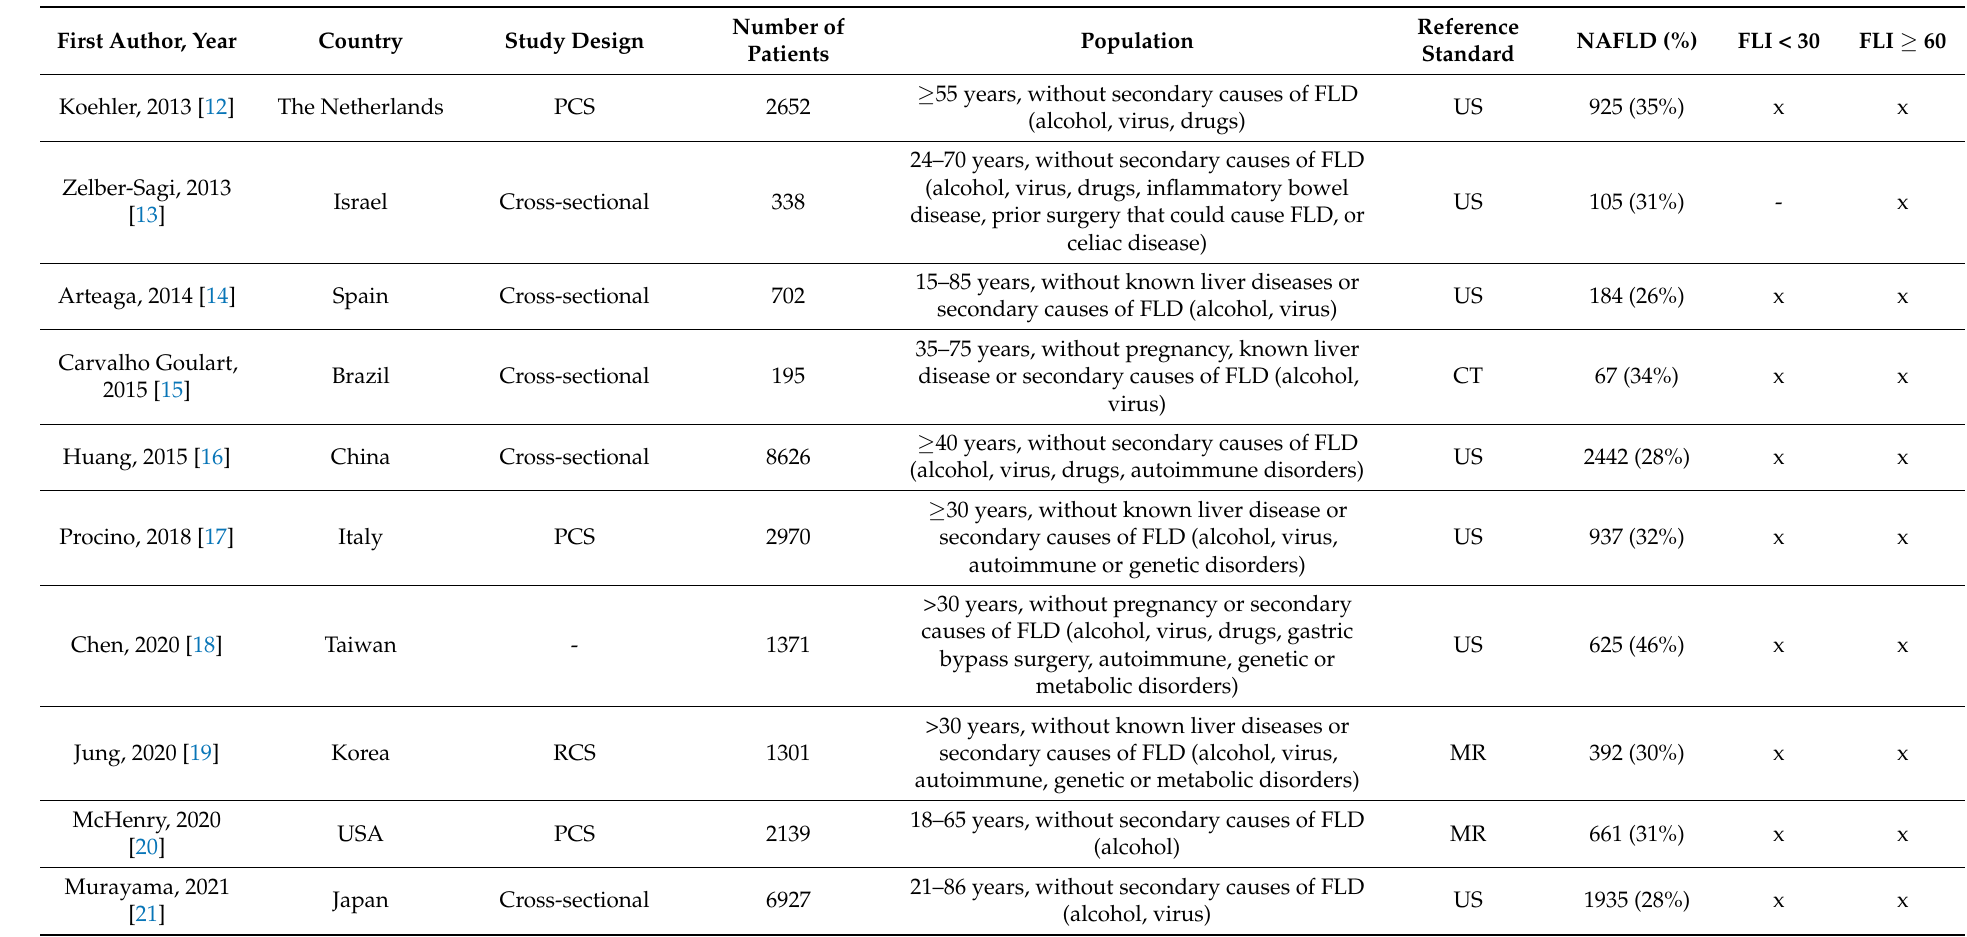
Table 1. Characteristics of included studies and availability of